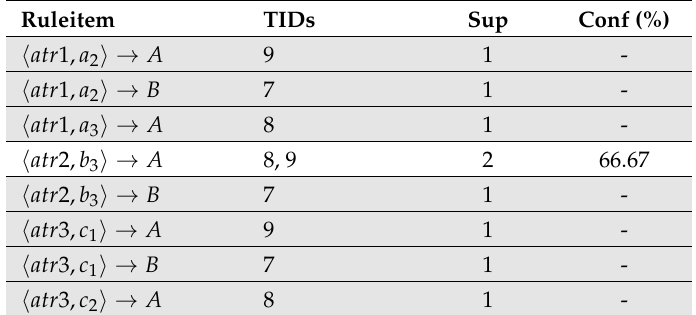
Table 5. Transaction IDs after generating the second CAR.